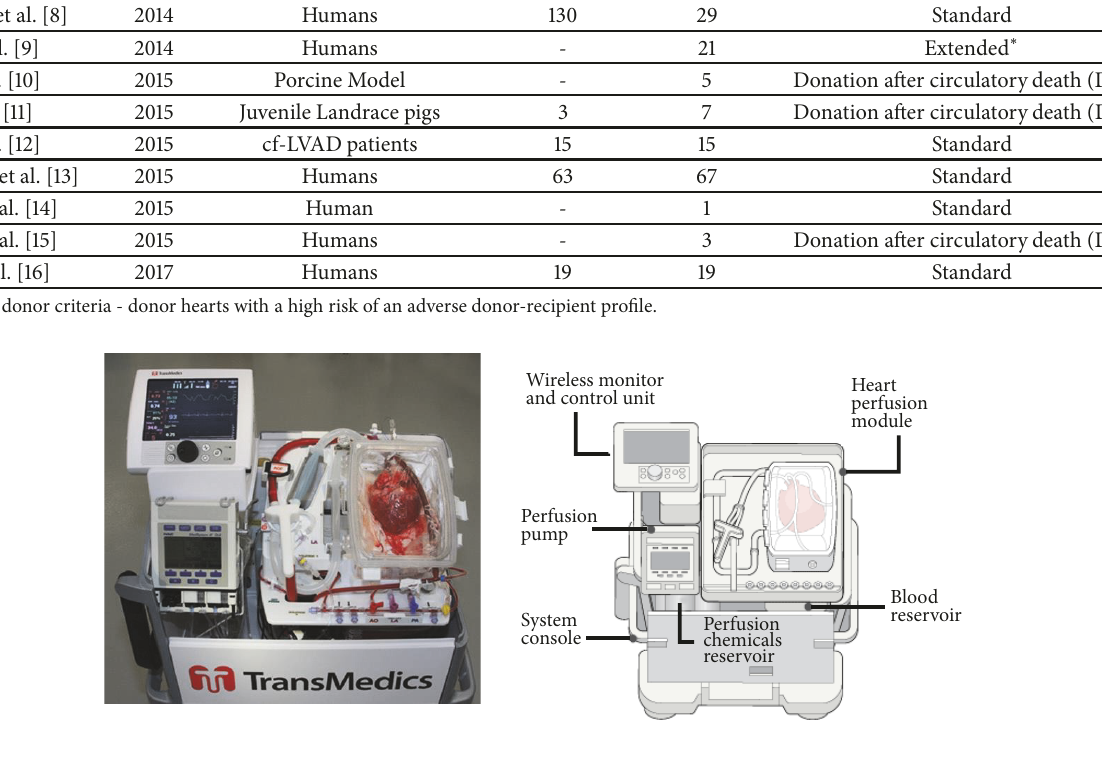
Figure 2: Organ care system with ex vivo perfusion of a human heart